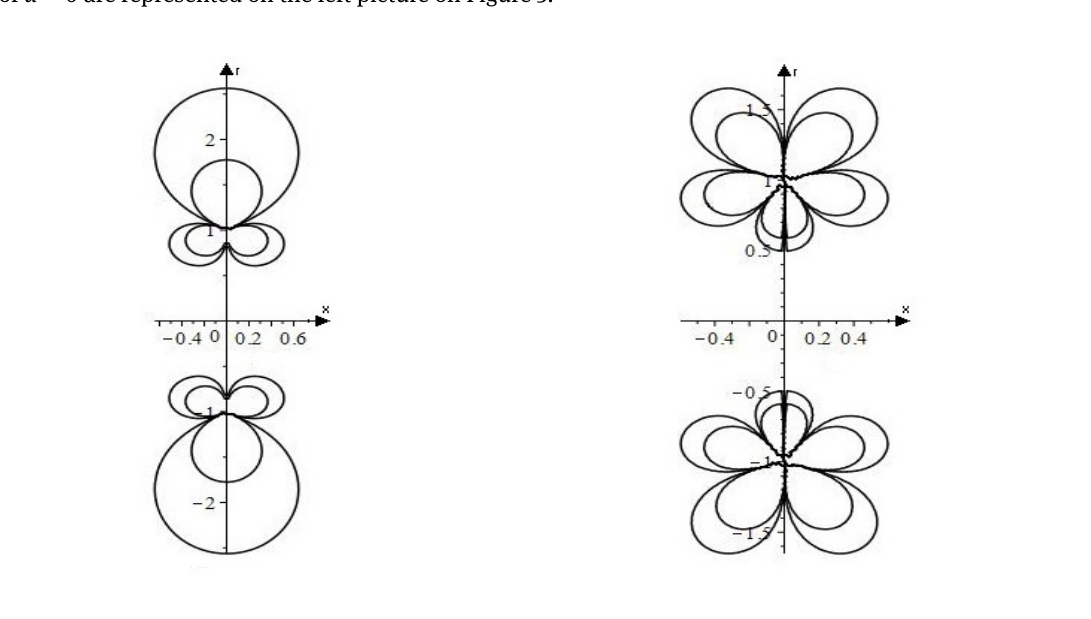
Figure 3: Pseudodipoles and